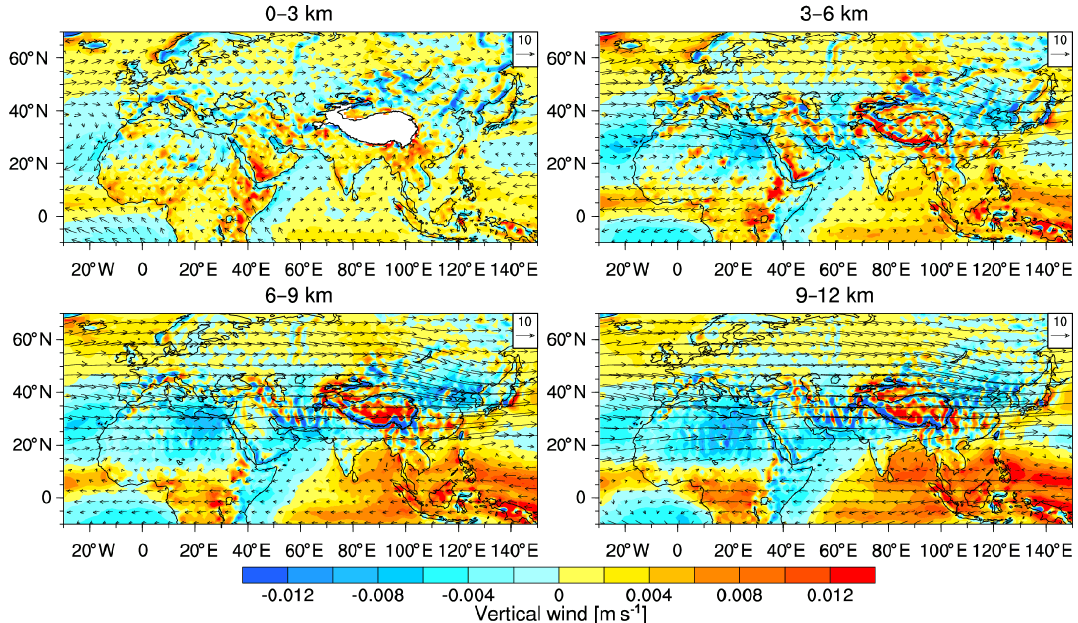
Figure 5. Annual mean wind field between 0–3, 3–6, 6–9, and 9–12km from the WRF-Chem simulations for the period of 2010–2015. The arrows indicate the horizontal wind (meters per second). The colors indicate the vertical wind velocity (meters per second) and positive values are for updrafts and negative values are for